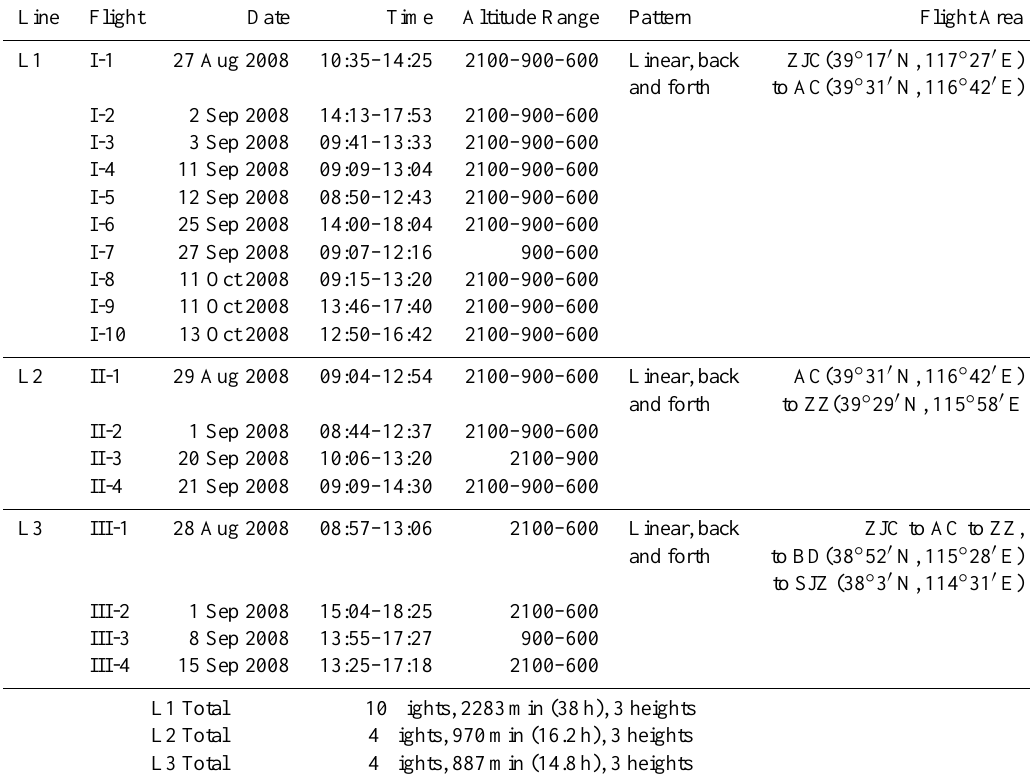
Table 1. The flight time, range, pattern, area and related information for different flight lines.